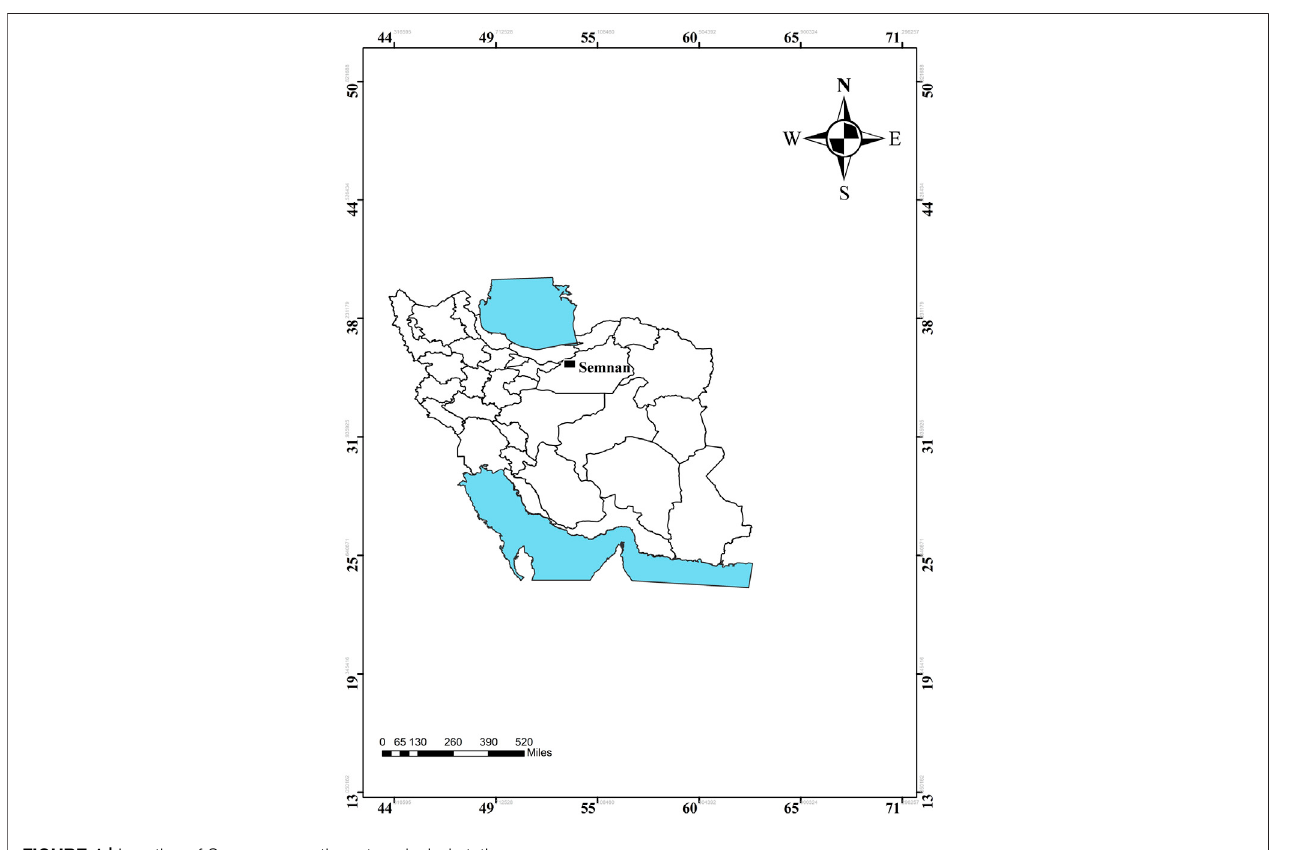
FIGURE 1 | Location of Semnan synoptic meteorological station.